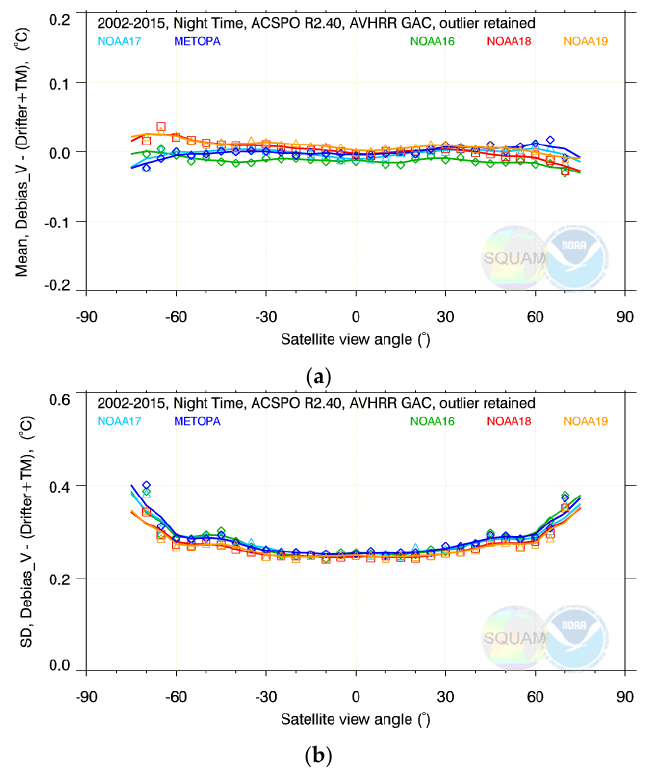
Figure 11. View zenith angle (VZA) dependencies of ( a ) mean biases and ( b ) SDs of Δ T S = T S − T in situ in RAN1 from all matchups aggregated by platform.